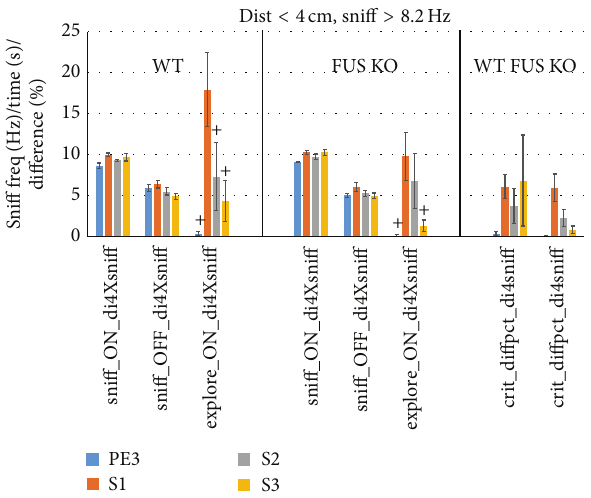
Figure 14: New combined proximity-sniffing criterion improves HaXha exploration scoring in mice. To demonstrate the usefulness of using sniff rate itself as an exploration criterion for WT (left, 𝑛 = 7 ) and FUS KO (right, 𝑛 = 13 ) mice, bins were scored using sniff rate > 8.2Hz (the 97.5th percentile of sniff OFFdi4Xsniff, i.e., unusually high sniff rates when mice are not exploring) and distance < 4 cm.Sniffrate(Hz)whenexploring(sniff ON di4Xsniff) and not exploring (sniff OFF di4Xsniff) and exploration time (s; explore ON di4Xsniff) are shown. The difference (%) in time bins meeting this new and the standard criterion was also assessed (% overlap; crit diffpct div4sniff). + 𝑃 < 0.01 (paired 1-sided 𝑡 -test versus